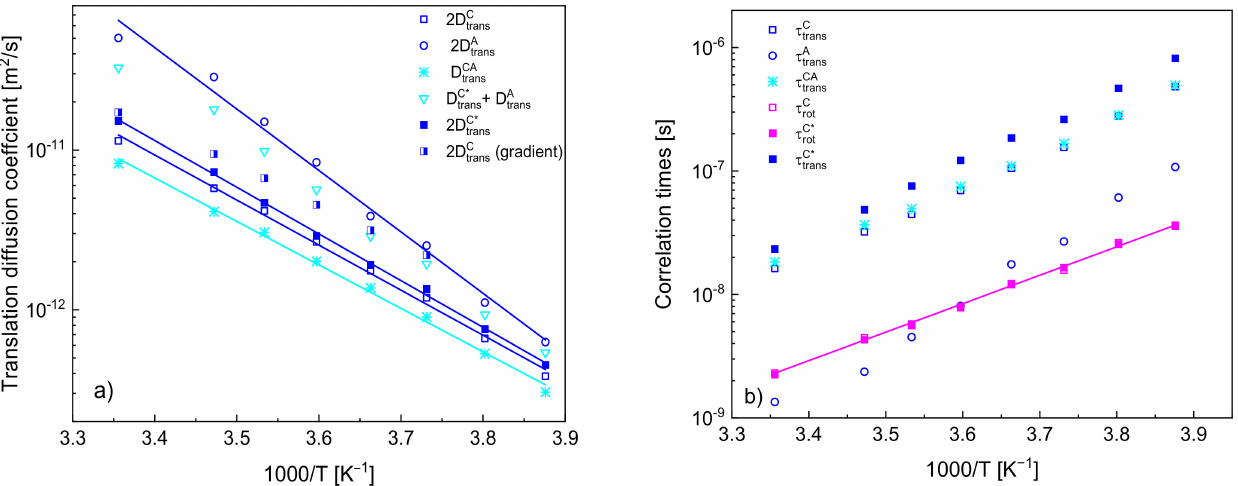
Figure 5. ( a ) Translation diffusion coefficients for [TEA-C4] cation and [TFSI] anion, solid lines—fits according to the Arrhenius law; ( b ) translational and rotational correlation times with a corresponding fit of the Arrhenius